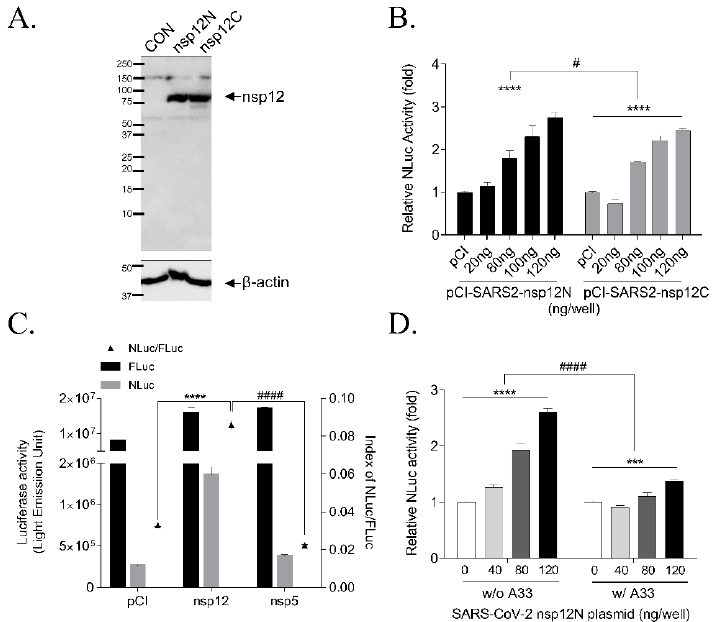
Figure 2. Expression of the SARS-CoV-2 RdRp gene and RdRp activity in a cell-based SARS-CoV-2 RdRp activity assay. ( A ) Expression of the SARS-CoV-2 RdRp gene with an N-terminal or C-terminal Flag was detected with an anti-Flag antibody by western blotting 24 h after transfection with pCI empty plasmid (CON), pCI-SARS2-nsp12N plasmid (nsp12N), or pCI-SARS2-nsp12C plasmid (nsp12C). ( B ) The activities of nsp12N and nsp12C were compared in a cell-based assay system by transfecting pCI-SARS2-nsp12N or pCI-SARS2-nsp12C and p(+)FLuc-( − )UTR-NLuc at the indicated concentrations for 24 h. The NLuc value was normalized to that of FLuc and analyzed by two-way ANOVA with Bonferroni’s multiple comparison tests [ n = 3, **** p < 0.0001, plasmid dosage effect, F(4, 20) = 81.90; # p = 0.0205, Flag tag effect, F(1, 20) = 6.337; ns, p = 0.3754, Flag tag times plasmid dose interaction, F(4, 20) = 1.119]. ( C ) NLuc activity was increased by transfection with pCI-SARS2-nsp12N (nsp12) but not with pcDNA3.1-SARS2-nsp5N (nsp5). After FLuc and NLuc activities were measured, NLuc/FLuc values were graphed. The results were analyzed by one-way ANOVA with Bonferroni’s multiple comparison tests [ n = 3, F(2, 6) = 672.2, **** p < 0.0001 vs. pCI, #### p < 0.0001 vs. nsp5]. ( D ) The p(+)FLuc-( − )UTR-NLuc reporter plasmids with or without polyA 33 were compared by transfection with pCI-SARS2-nsp12N and p(+)FLuc-( − )UTR-NLuc without poly-A 33 (w/o A 33 ) or with poly-A 33 (w/ A 33 ) at the indicated concentrations. The relative NLuc activities (normalized by FLuc activity) of the two groups were compared using two-way ANOVA followed by Bonferroni’s multiple comparison [ n = 3; **** p < 0.0001, dose-effect, F(3, 8) = 89.08; *** p = 0.0001, dose-effect F(3, 8) = 29.31; #### p < 0.0001; poly-A 33 effect, F(1, 16) = 200.7]. It was representative of at least three independent experiments. The data were presented as mean ± standard error of the